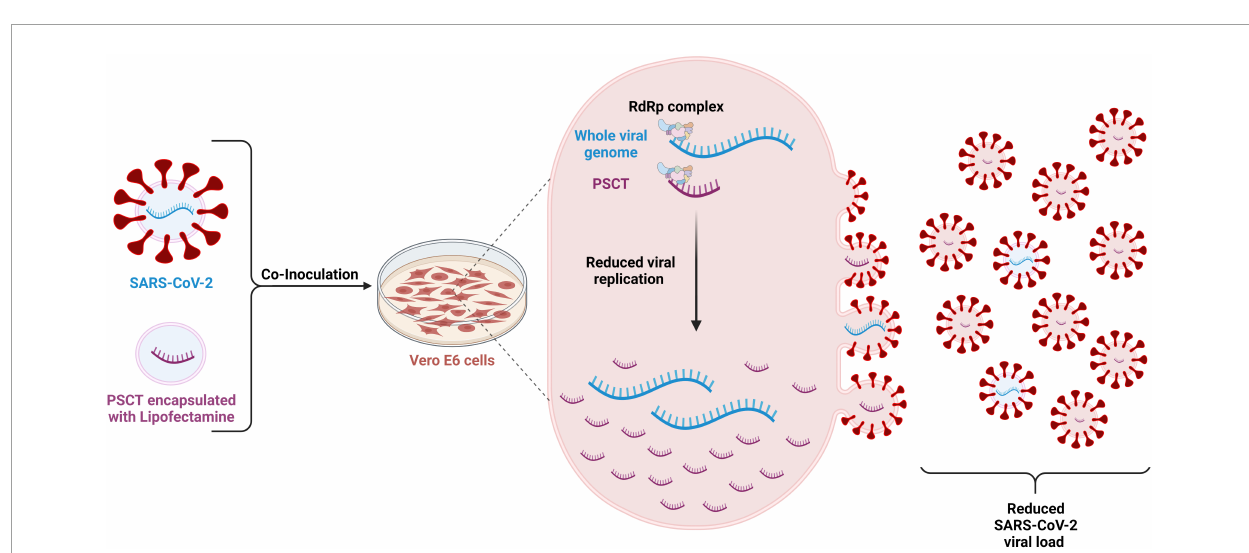
FIGURE6 Schematic illustration of the methodology and proposed mechanism of action of the PSCT treatment. The mRNA-PSCT/liposome complexes were prepared in advance using lipofectamine-MessengerMAX TM transfection reagent as recommended by the manufacturer. Vero E6 cells were infected with SARS-CoV-2 viral stock at low MOI (0.01) for 1 h, and then the cultures were then treated once with liposome-encapsulated PSCT or with mock transfection. At 4 h post transfection, we aspirated the supernatant and replaced it with standard culture media, as detailed in methods. The supernatants and cell lysates were collected at 24, 48, and 72 h p.i., and analyzed for SARS-CoV-2 genome load and PSCT levels by multiplex qPCR. Our results imply that the liposome-encapsulated PSCT molecules were effectively delivered intracellularly and significantly inhibited the replication of SARS-CoV-2 genome by the viral replicase-transcriptase complex. Furthermore, our data regarding the release of PSCT and standard SARS-CoV-2 genome from infected cells into the extracellular milieu suggest that PSCT competed with the viral genome for packaging into viral particles. Created with BioRender.com (agreement number: